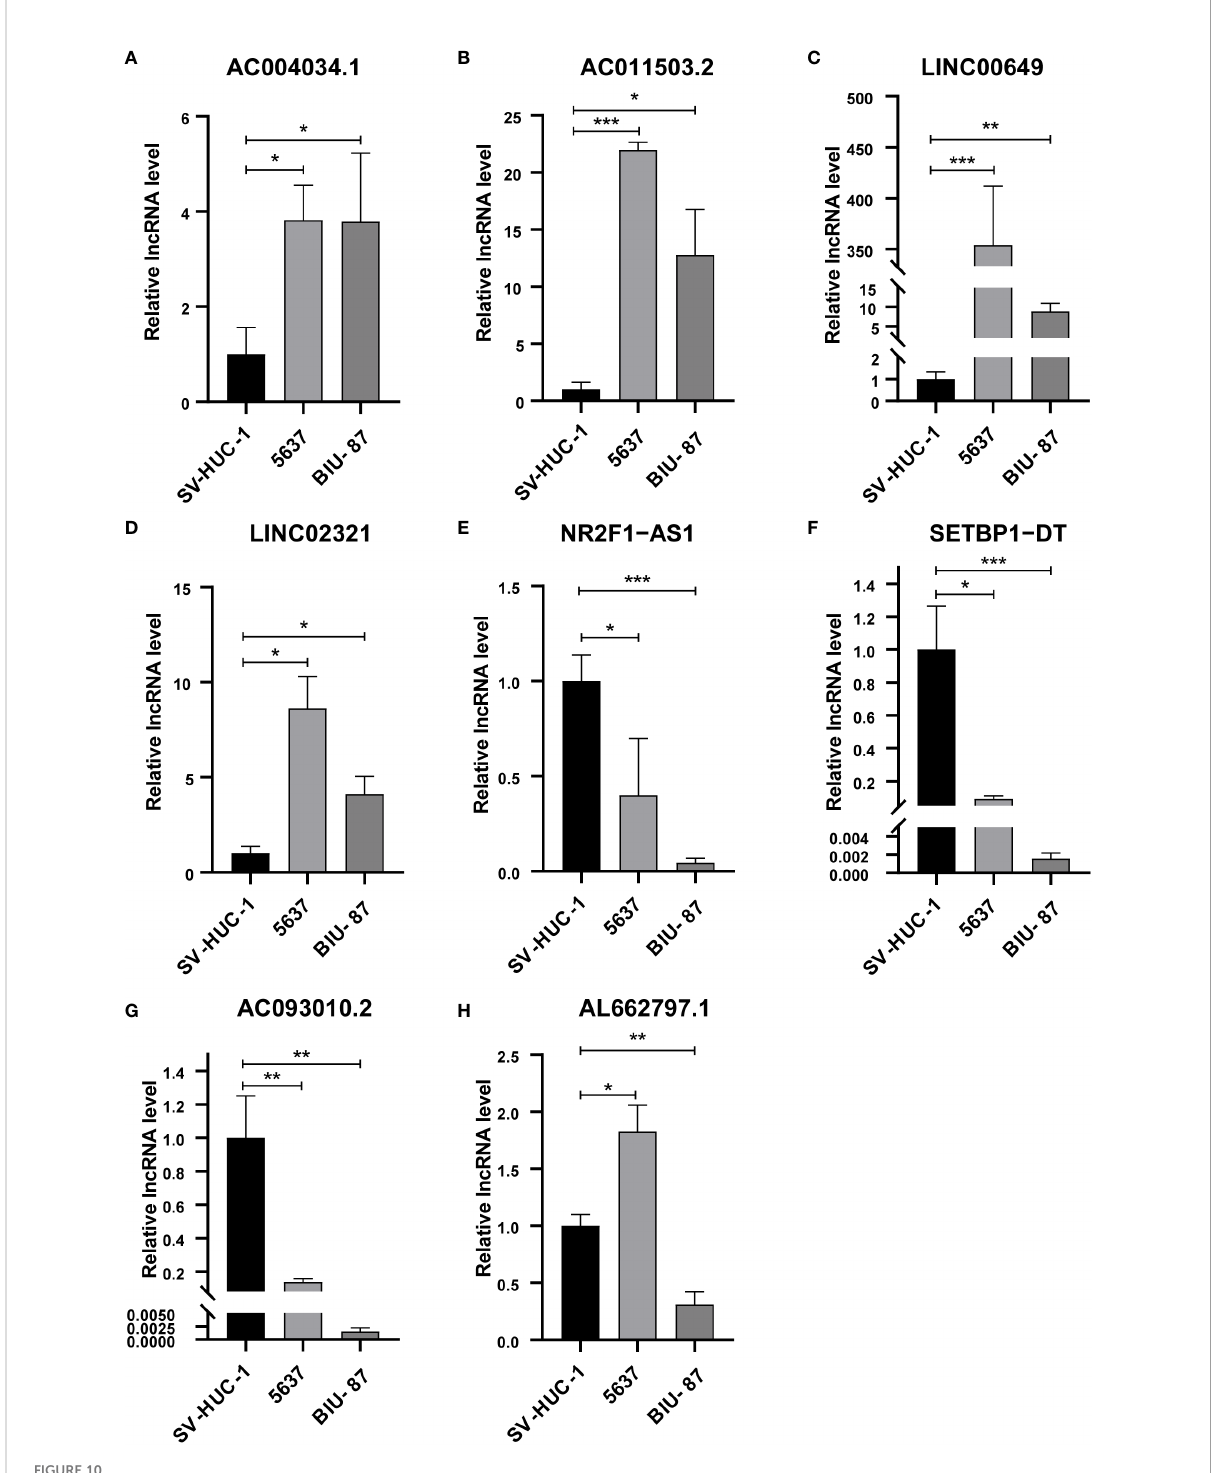
FIGURE 10 qRT-PCR for detection of lncRNA expression levels in a risk model in BCa cells. (A) AC004034.1 (B) AC011503.2 (C) LINC00649 (D) LINC02321 (E) NR2F1-AS1 (F) SETBP1-DT (G) AC093010.2 (H) AL662797.1 * P < 0.05, ** P < 0.01, *** P <